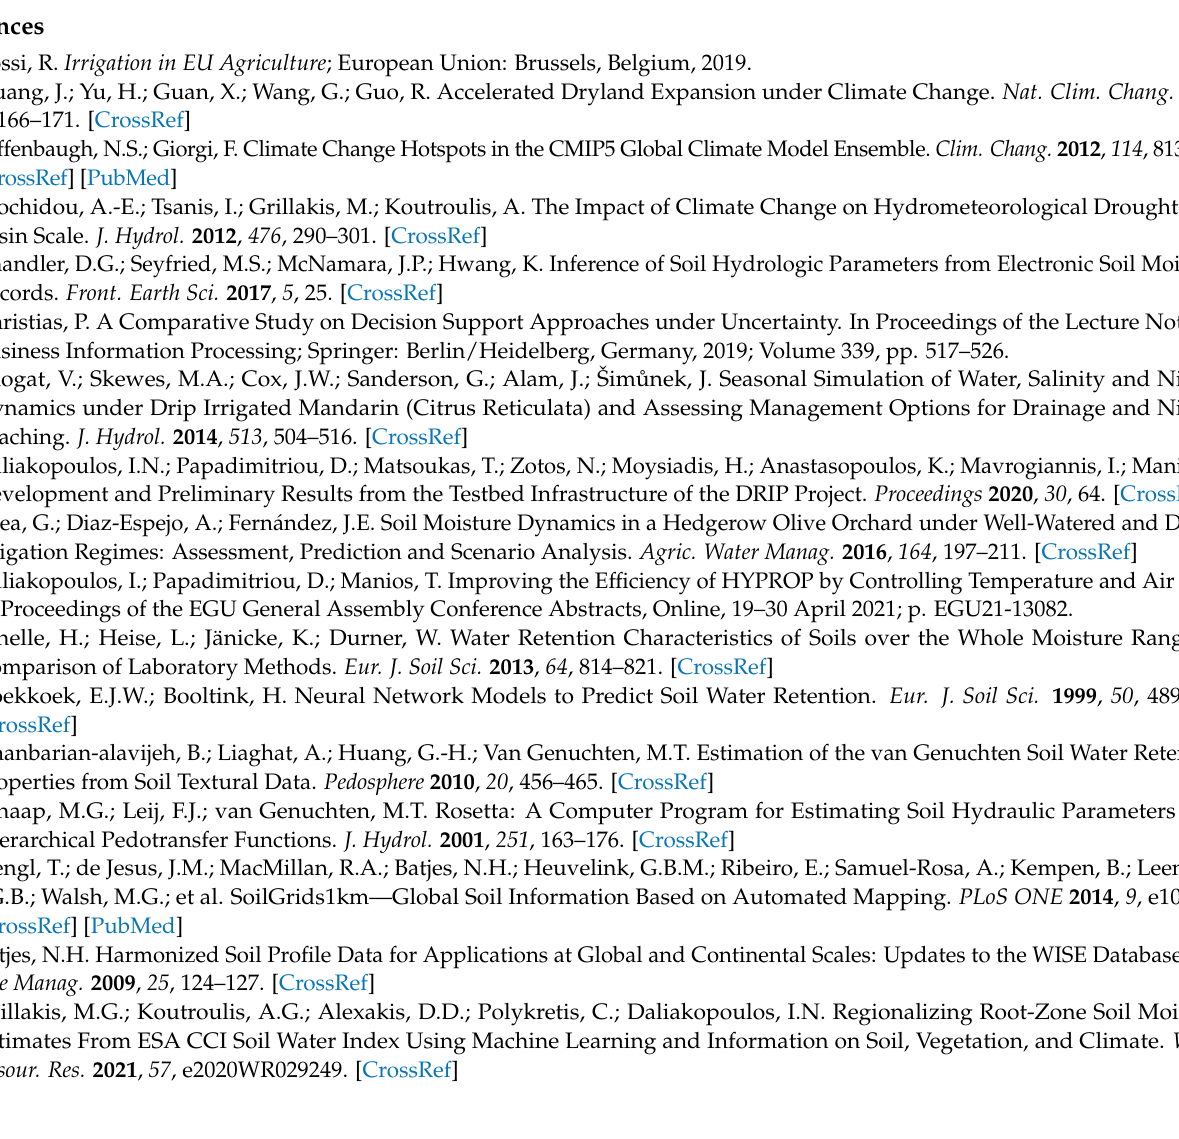
Figure A3. Representative sections ( a – e ) showing the geological formations in the study